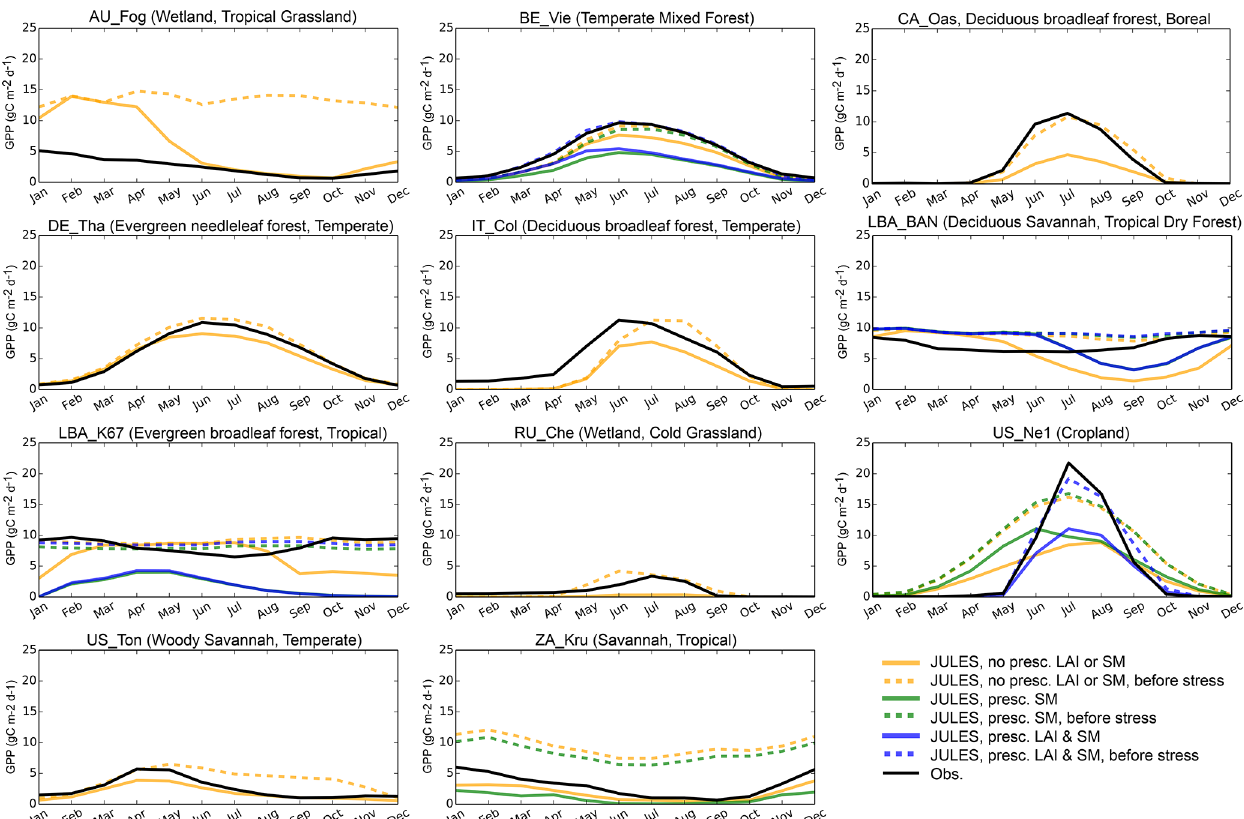
Figure 6. Average seasonal cycle of GPP (gCm − 2 d − 1 ) for representative sites in biomes with large biases. Full dates of simulations are provided in the Supplement; here we give the years that are included in each simulation: AU-Fog (2006–2008), BE-Vie (1996–2006),